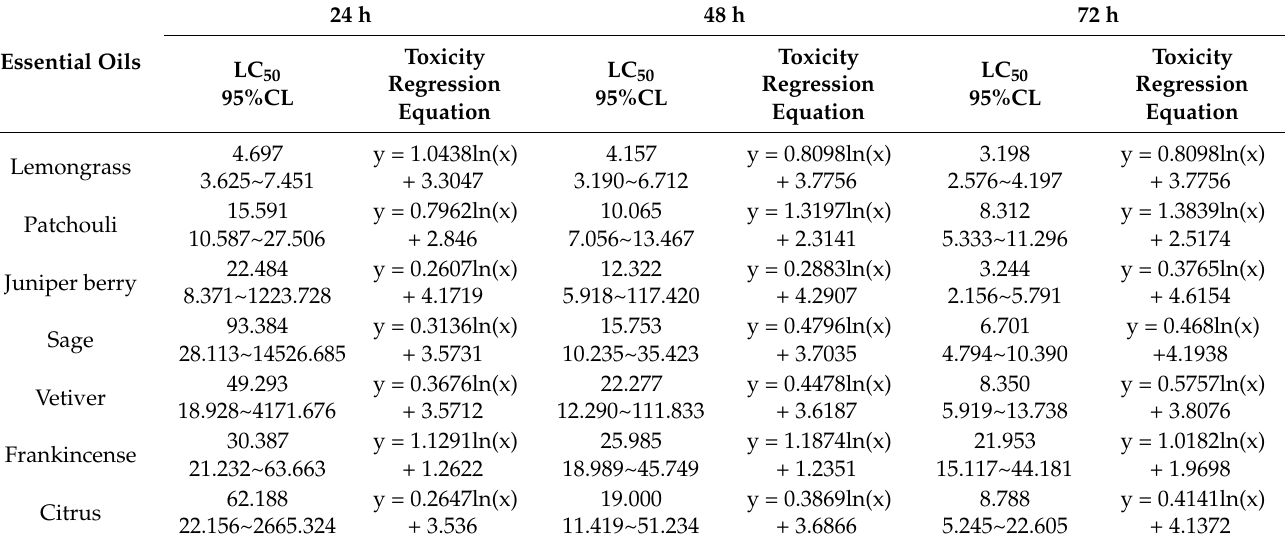
Table 1. Median lethal concentration, 95% confidence limit, and toxicity regression equation of Panonychus citri treated with essential oils at different times.